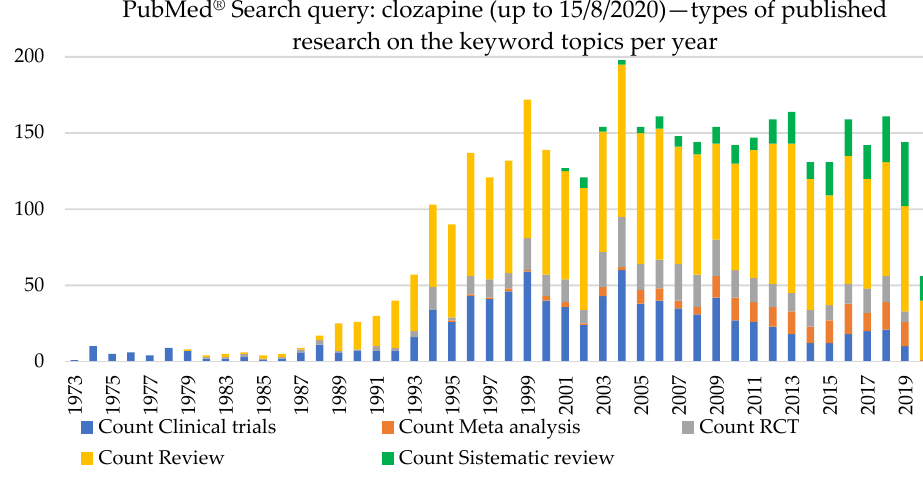
Figure 2. A systematic search for the keyword “clozapine” on the PubMed ® database (all-time topic) retrieved over 3075 results by type of study.